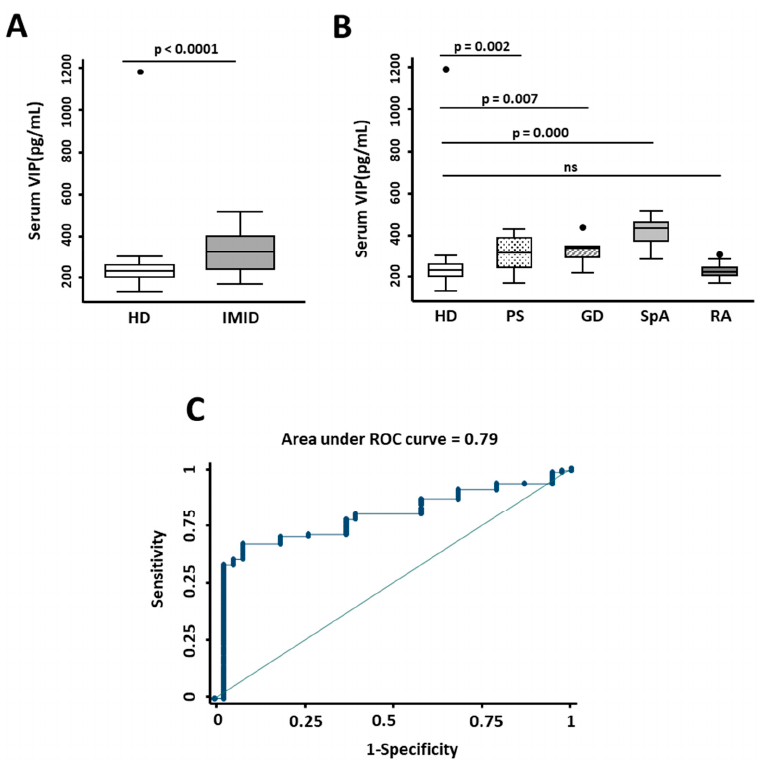
Figure 1. Expression of serum VIP levels in inflammatory/autoimmune pathologies. ( A ) Determination of serum VIP levels (pg/mL) by ELISA of 38 healthy donors (HD) and 52 patients with immune-mediated inflammatory diseases (IMID). Statistical significance was determined using the variable of serum VIP levels normalized by inverse square root and Student’s t -test to obtain p -value < 0.0001. ( B ) Serum VIP levels (pg/mL) of 38 healthy donors (HD) and 15 patients with psoriasis (PS), 8 with Graves’ disease (GD), 15 with spondyloarthritis (SpA), and 14 with rheumatoid arthritis (RA) are shown. Statistical significance was calculated using the variable of serum VIP levels normalized by inverse square root and applying ANOVA and Bonferroni correction for multiple comparisons to obtain p -values as indicated. In all panels, data are presented as the interquartile range (p75: upper edge of the box, p25: bottom edge of the box, and p50: midline) and p90 and p10 (lines below and above the box) of the serum VIP levels. Dots represent outliers. Significance threshold was set at p < 0.05. ( C ) The graph shows the receiver operating characteristic (ROC) curve analysis to assess the ability of serum VIP levels to discriminate between patients with IMID and healthy donors. Area under ROC curve is indicated in the